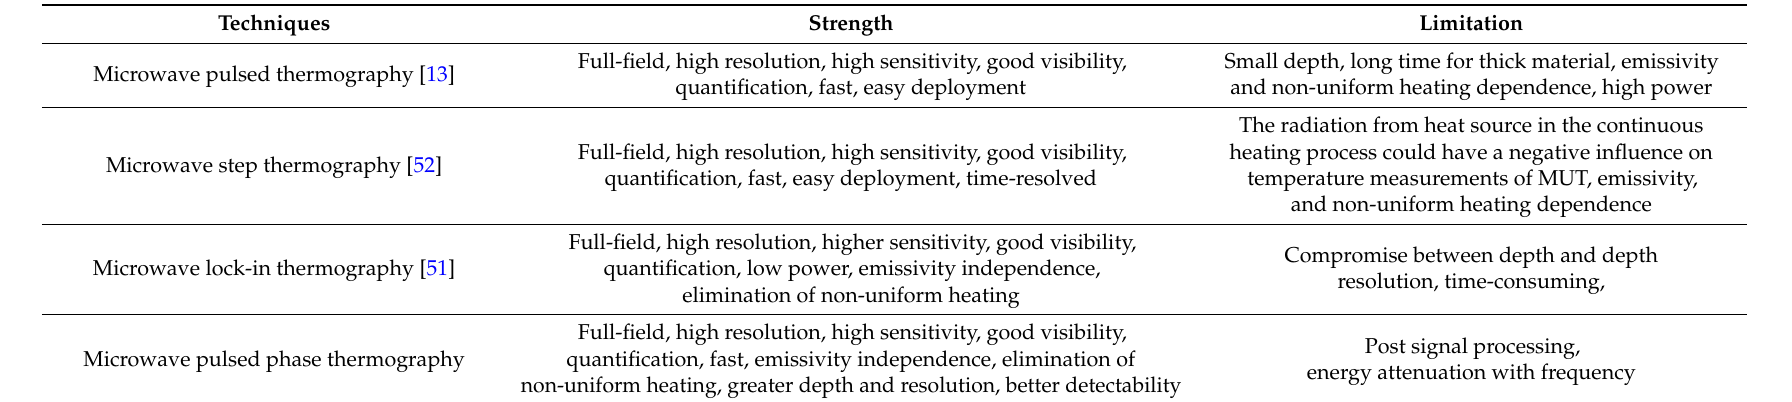
Table 1. Comparisons among MPT, MST, MLT and